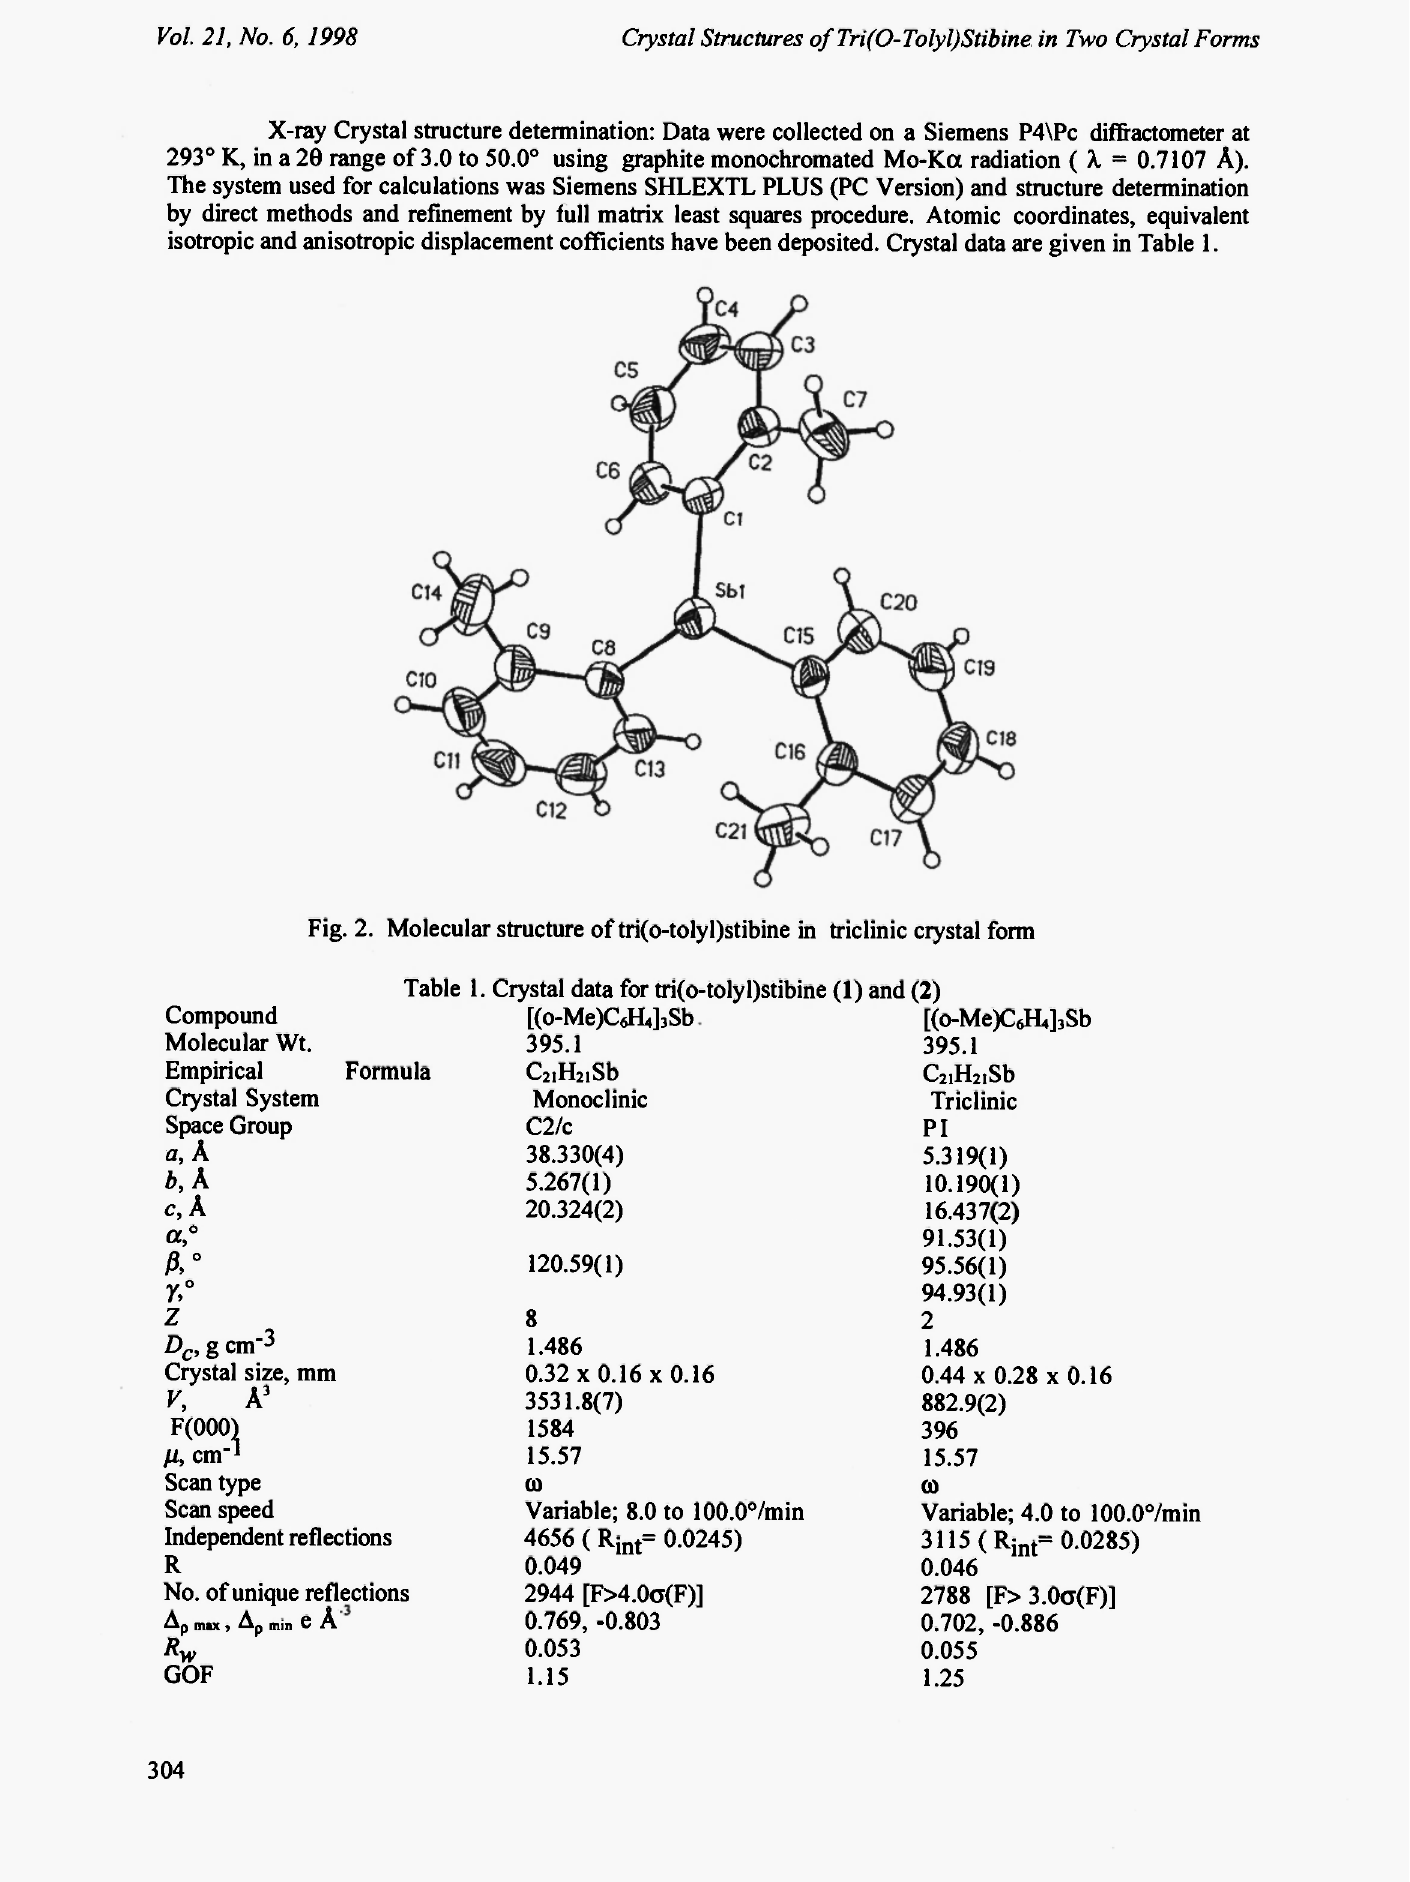
Fig. 2. Molecular structure of tri(o-tolyl)stibine in triclinic crystal form Table 1. Crystal data for tri(o-tolyl)stibine (1) and